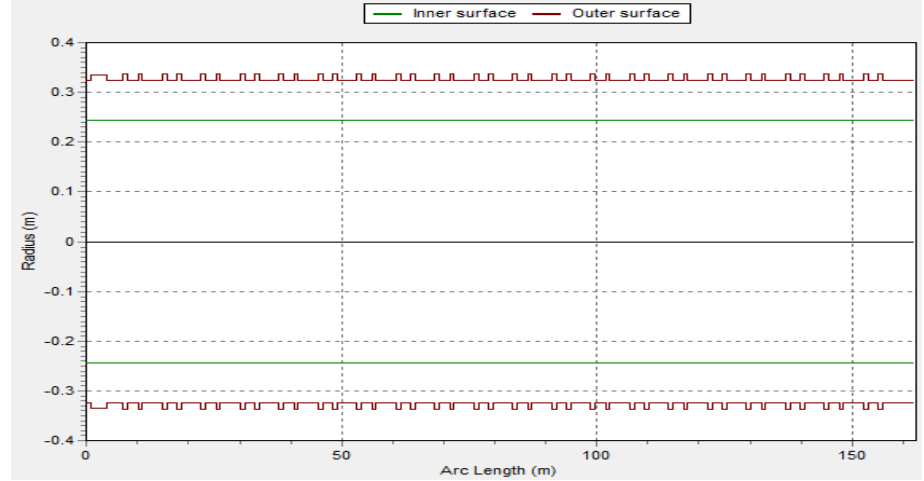
m Table 3. Parameters for the submarine hose for Lazy-S configuration with section details arrange- ment. Section Number